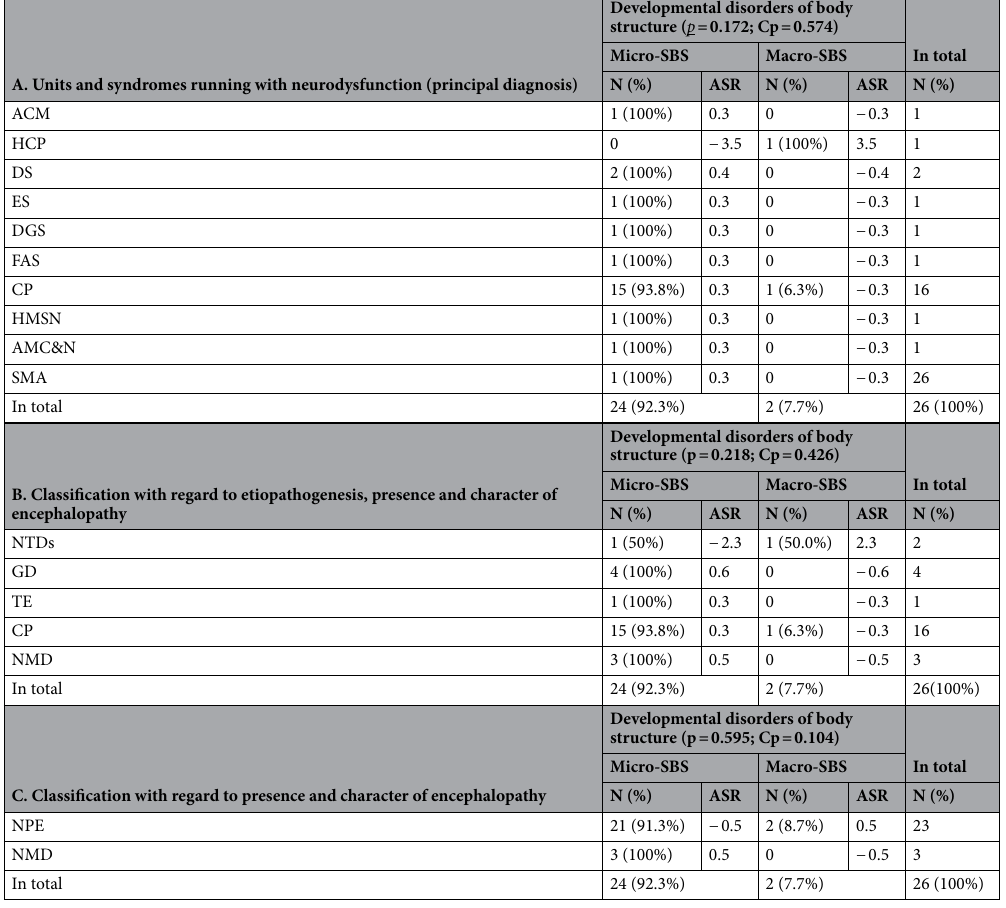
Table 2. Developmental disorders of body structure and: principal diagnosis (A), classification of encephalopathy (B-C). micro-SBS microsomic body structure, macro-SBS macrosomic body structure, ACM Arnold-Chiari malformation, HCP isolated hydrocephalus, DS Down’s syndrome, ES Edwards syndrome, DGS DiGeorge syndrome, FAS fetal alcohol syndrome, CP cerebral palsy, HMSN hereditary motor and sensory polyneuropathy, AMC&N arthrogryposis multiplex congenita with neuropathy, SMA spinal muscular atrophy, NTDs neural tube defects, GD genetic disorders, TE toxic encephalopathy, CP cerebral palsy, NMD neuromuscular disorders, NPE non-progressive encephalopathy, NMD neuromuscular disorders, N numbers of patients, % percent, p probability value calculated by chi-square test of independence,